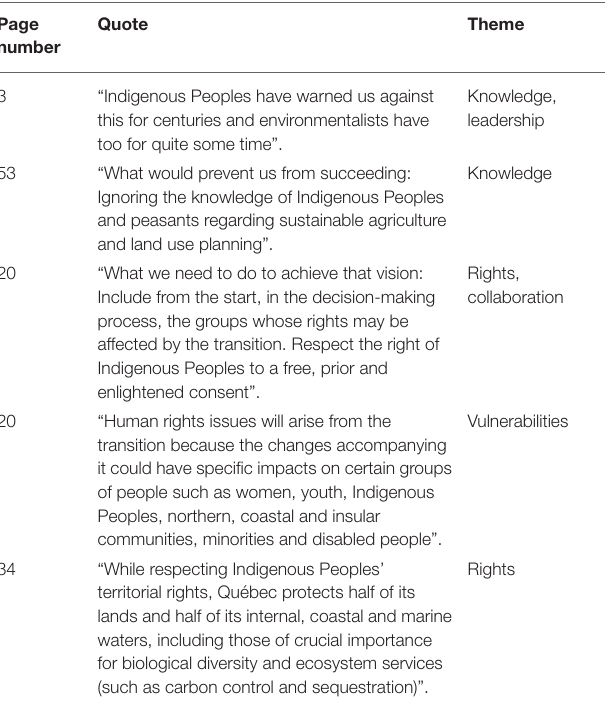
TABLE 1 | Example mentions of the word “Indigenous” in the PCF. TABLE 2 | Example mentions of the word “Indigenous” in the